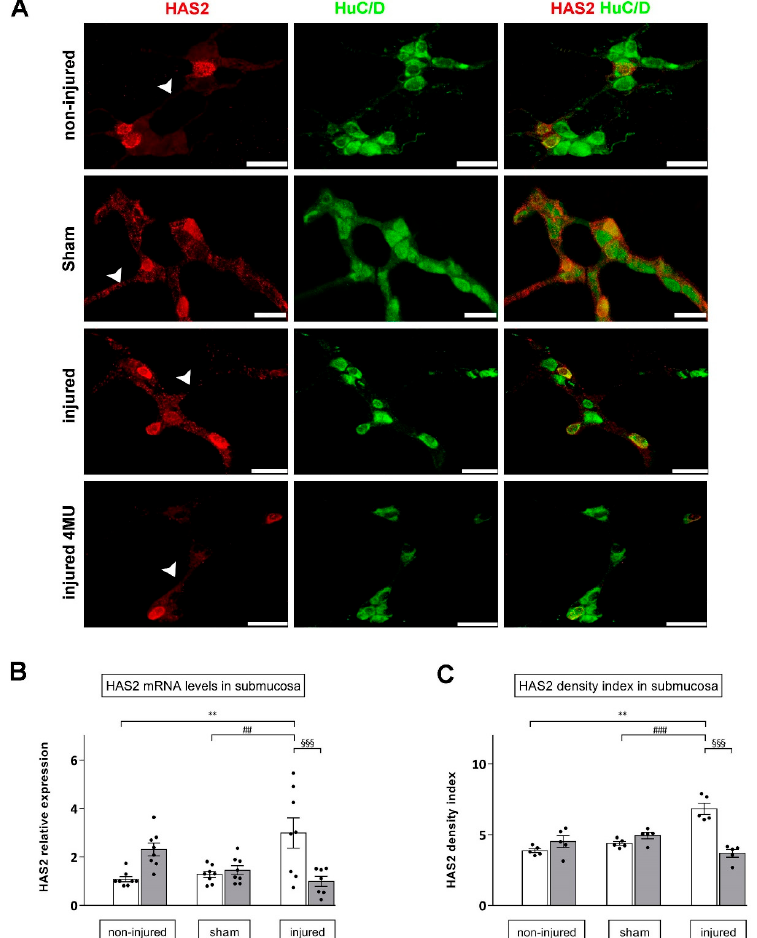
Figure 5. Immunofluorescence staining and qRT-PCR reveal increased HAS2 expression in the rat small intestine submucosal plexus after IRI injury. ( A ) Confocal microphotographs of HAS2 and HuC/D co-localization in submucosal neurons of CTR, sham-operated animals, after IRI injury and in the 4-MU-treated injured group. HAS2 stained the soma of ovoid submucosal neurons. Scale bar = 50 µm. ( B ) HAS2 mRNA levels in submucosal layer obtained from the different experimental groups, with (grey columns) or without (white columns) 4-MU treatment. Graphs show HAS2 relative gene expression to β -actin. §§§ p < 0.001, ** p < 0.01, ## p < 0.01 by one-way ANOVA with Tukey’s test. N = 6 rat/group. ( C ) Density index of HAS2 staining in the submucosal plexus obtained from the different experimental groups, with (grey columns) or without (white columns) 4-MU treatment. ###,§§§ p < 0.001, ** p < 0.01, p < 0.0001 by one-way ANOVA with Tukey’s test. N = 5